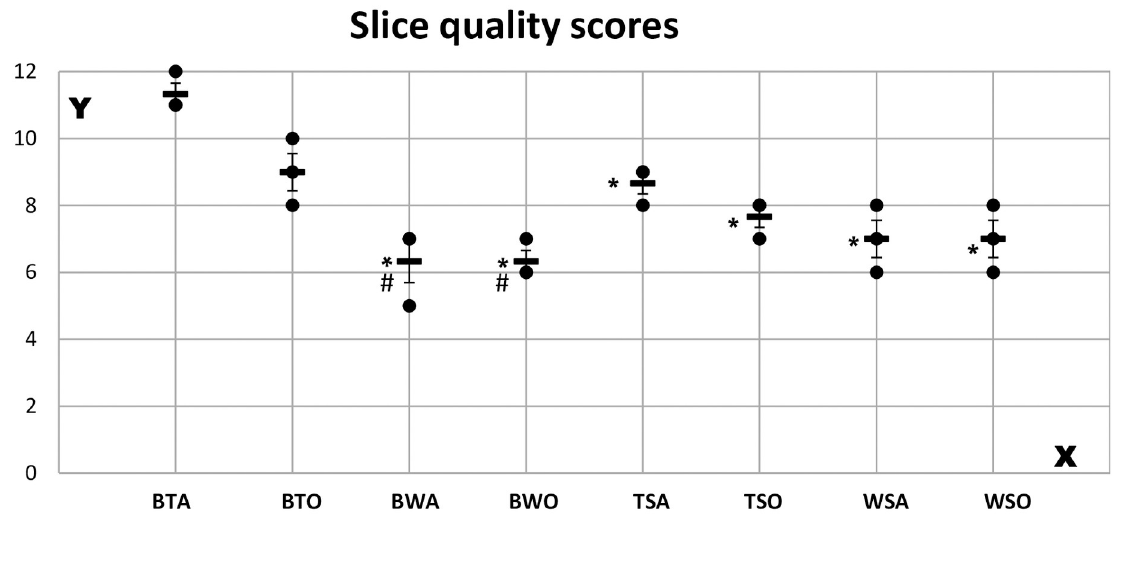
Fig 4. Slice quality comparison among different protocols. The average slice quality scores of the 3 best staining sections at the position of Bregma +3.90 mm (the best quality section among 10 in one head of animal) in the 8 protocols (X-axis) are shown in Y-axis.